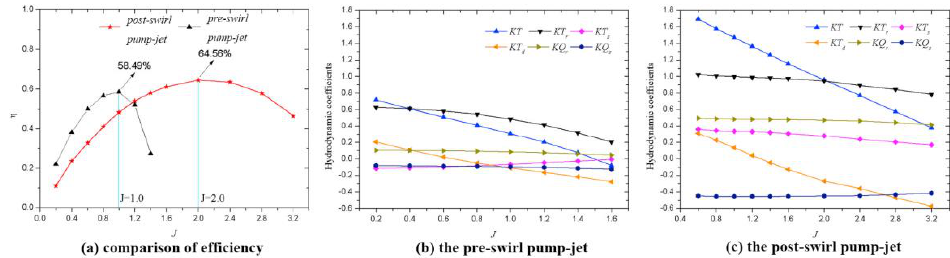
Figure 4. Hydrodynamic performance comparison between pre-swirl pump-jet and post-swirl pump-jet [19].